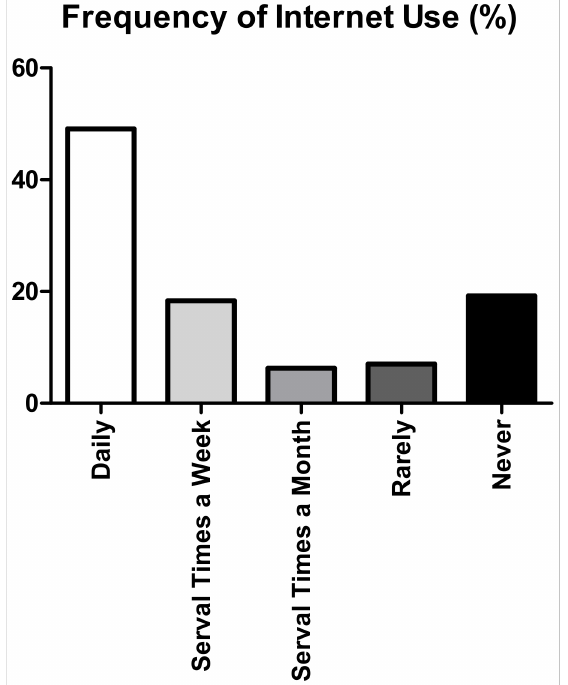
Figure 2. Frequency of Internet use. Descriptive bar chart showing the frequency of Internet use in our cohort. Most of the participants (<65%) reported frequent Internet usage. Nonetheless, 19.24% ( n = 132) of the participants never use the Internet.